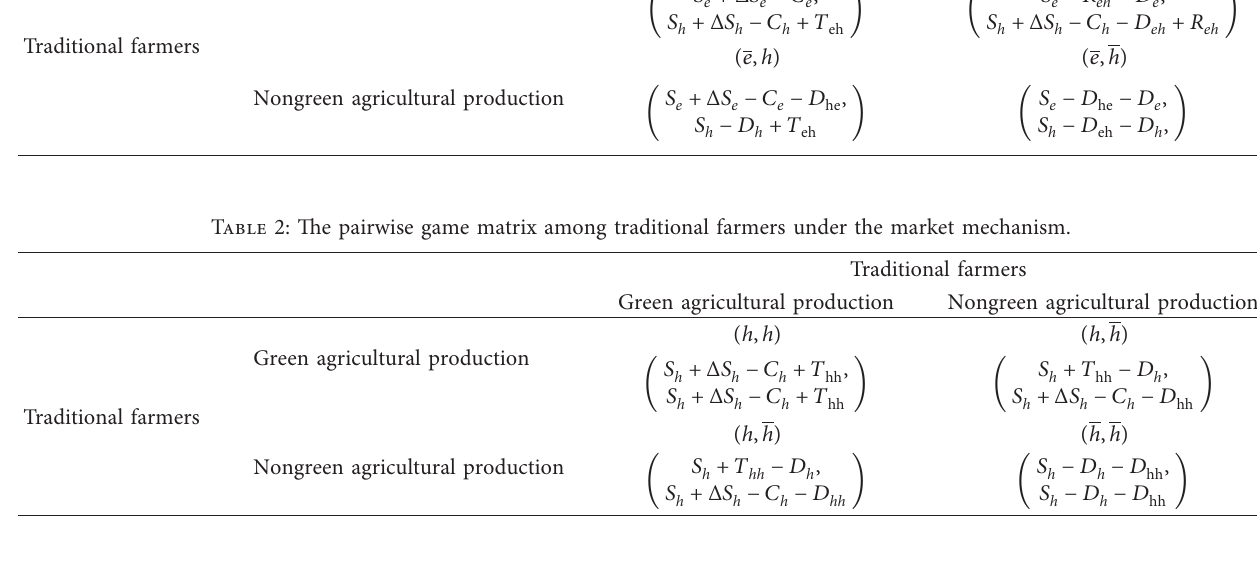
Table 3: The pairwise game matrix among new agricultural operation entities under the market